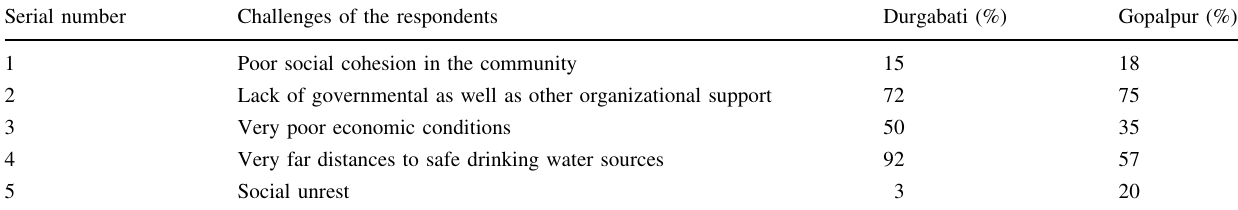
Table 3 Challenges of the respondents to implement adaptive practices in the two study villages of southwestern coastal